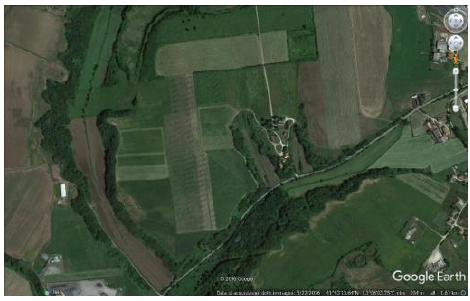
Figure 2. Monitoring